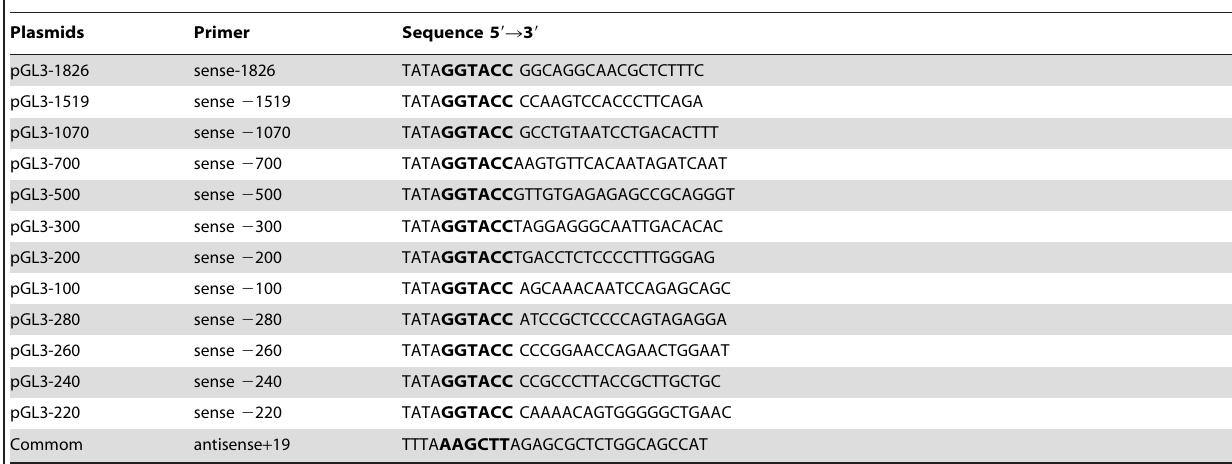
Table 1. Primers used for cloning the hTFF3 promoter.